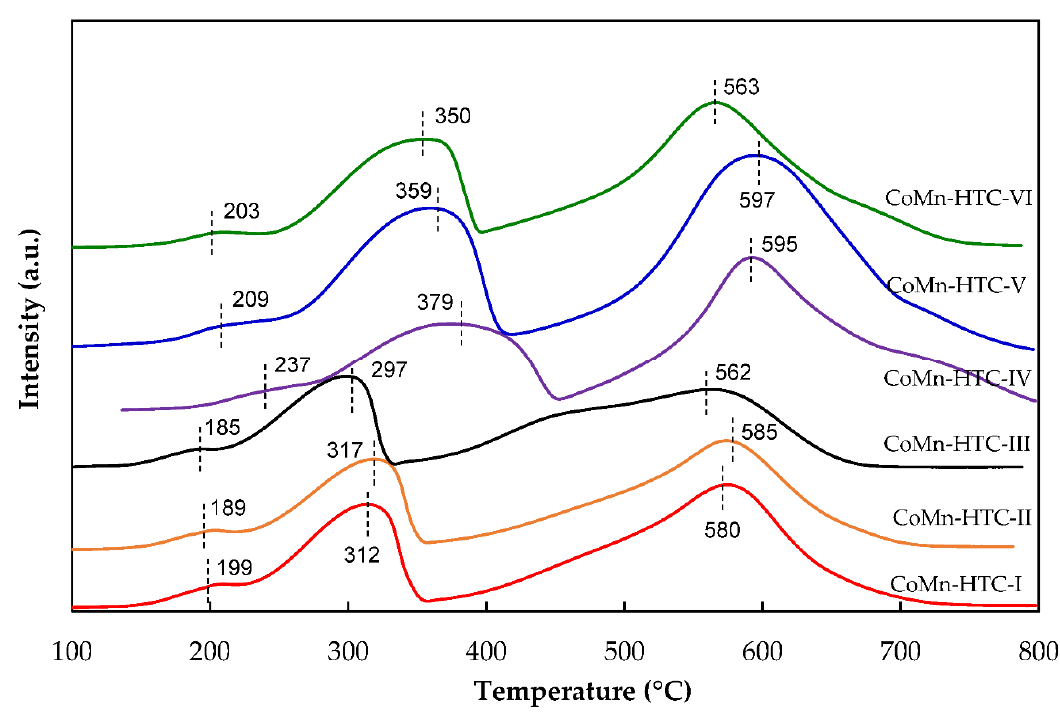
Figure 3. Hydrogen temperature-programmed reduction (H 2 -TPR) profiles of the CoMn-HTC catalysts.